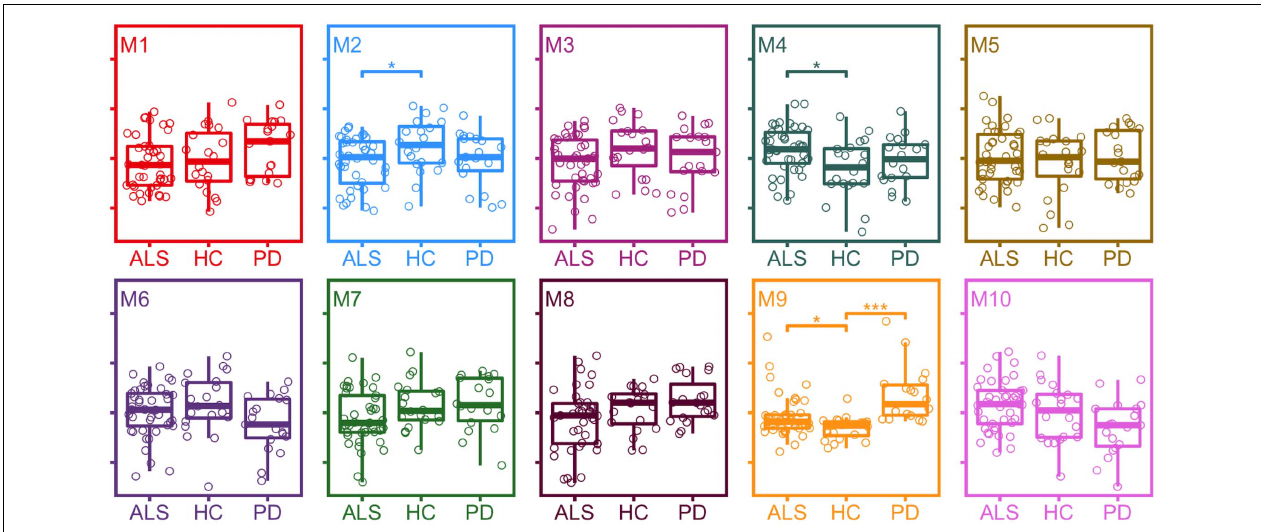
FIGURE 3 | Expression of module eigenproteins between conditions. * p < 0.05, ** p < 0.01, *** p < 0.001. ALS, amyotrophic lateral sclerosis; HC, healthy control; PD, Parkinson’s disease.